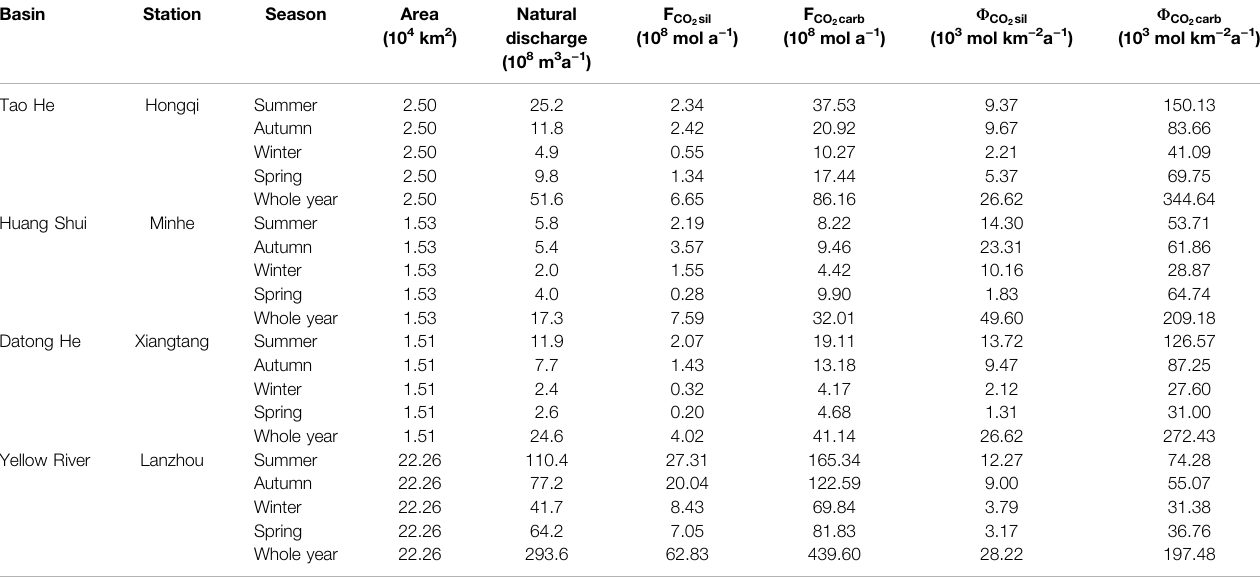
TABLE 4 | CO 2 consumption by chemical weathering at the outlets of the Tao He, Huang Shui, and Datong He, and Lanzhou station on the Yellow River mainstream in four seasons. Basin